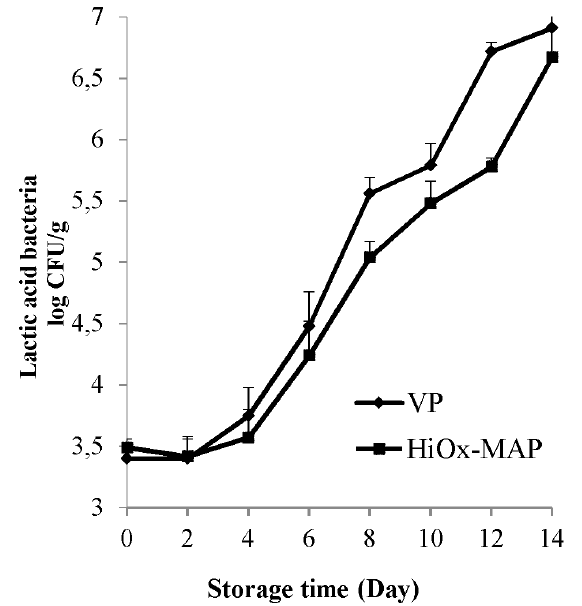
Figure 5. Effects of vacuum packaging (VP) and high-oxygen modified forming